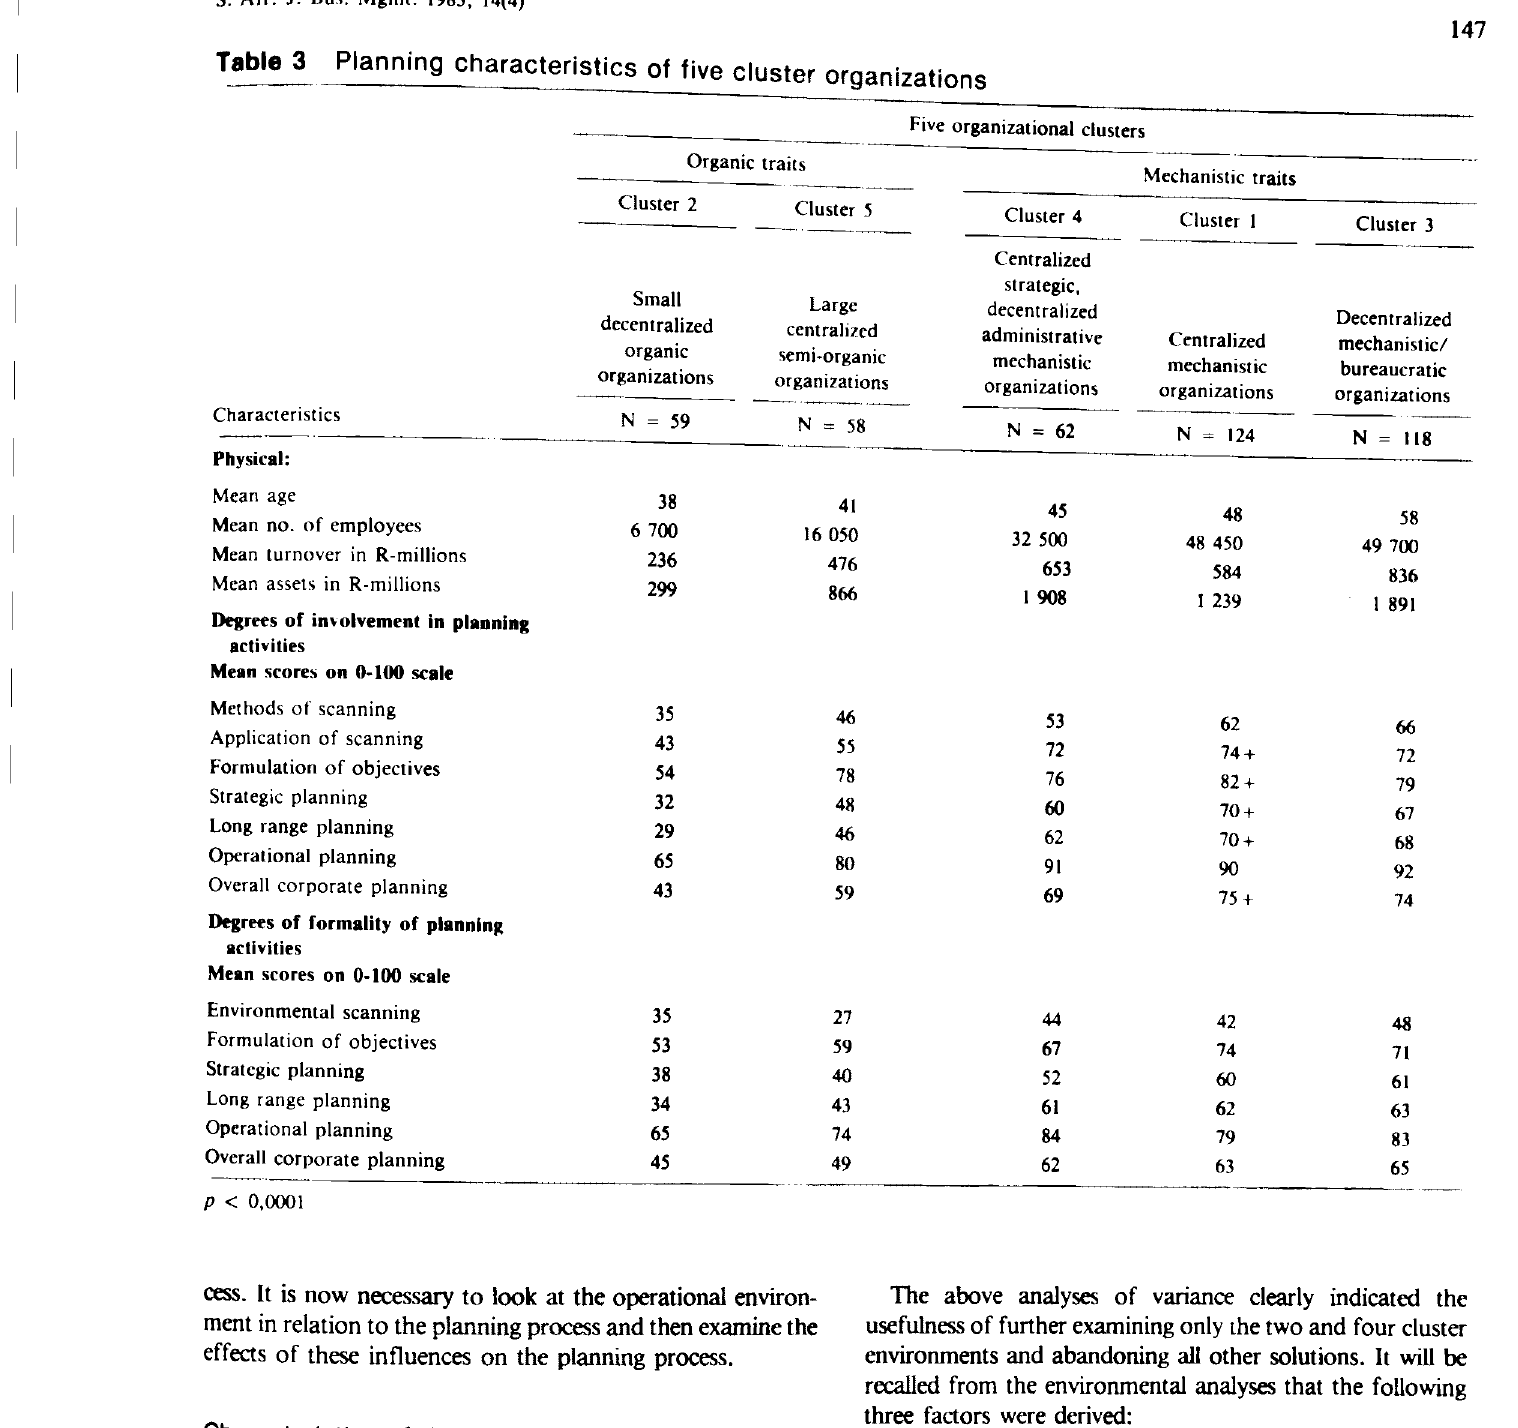
Five organizational